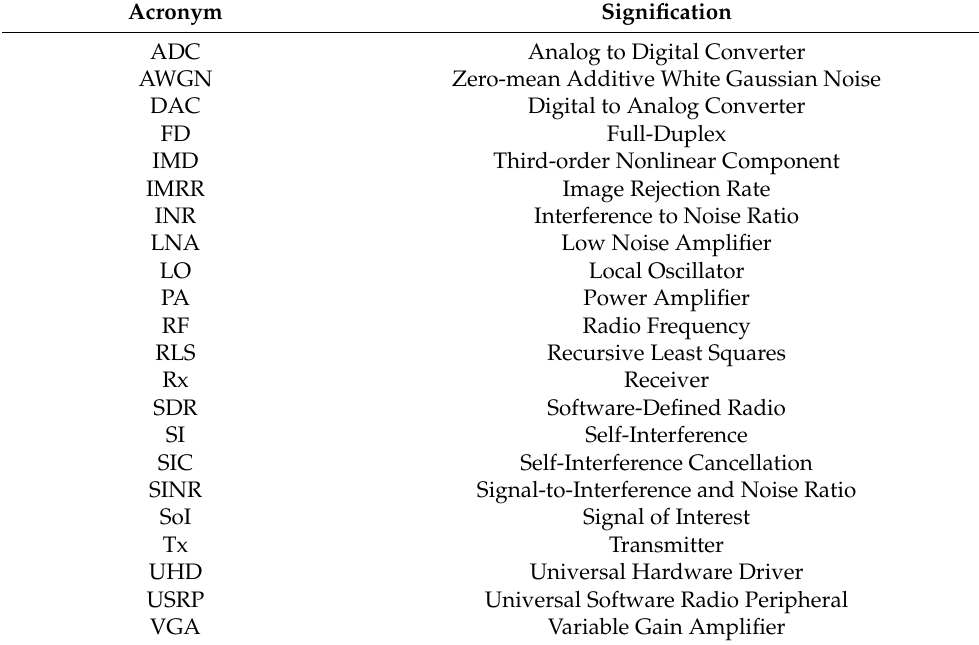
Table 1. Acronyms used throughout the